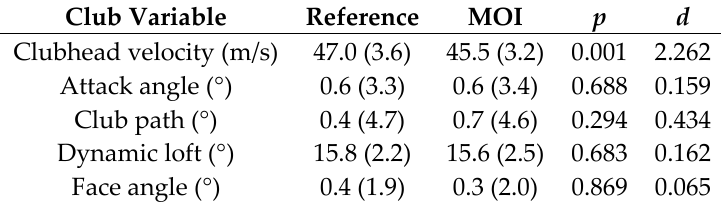
Table 2. Mean (SD) values of the clubhead delivery variables for both the reference and moment of inertia (MOI) conditions, along with outcomes ( p -value and effect size d ) from the paired t -tests.